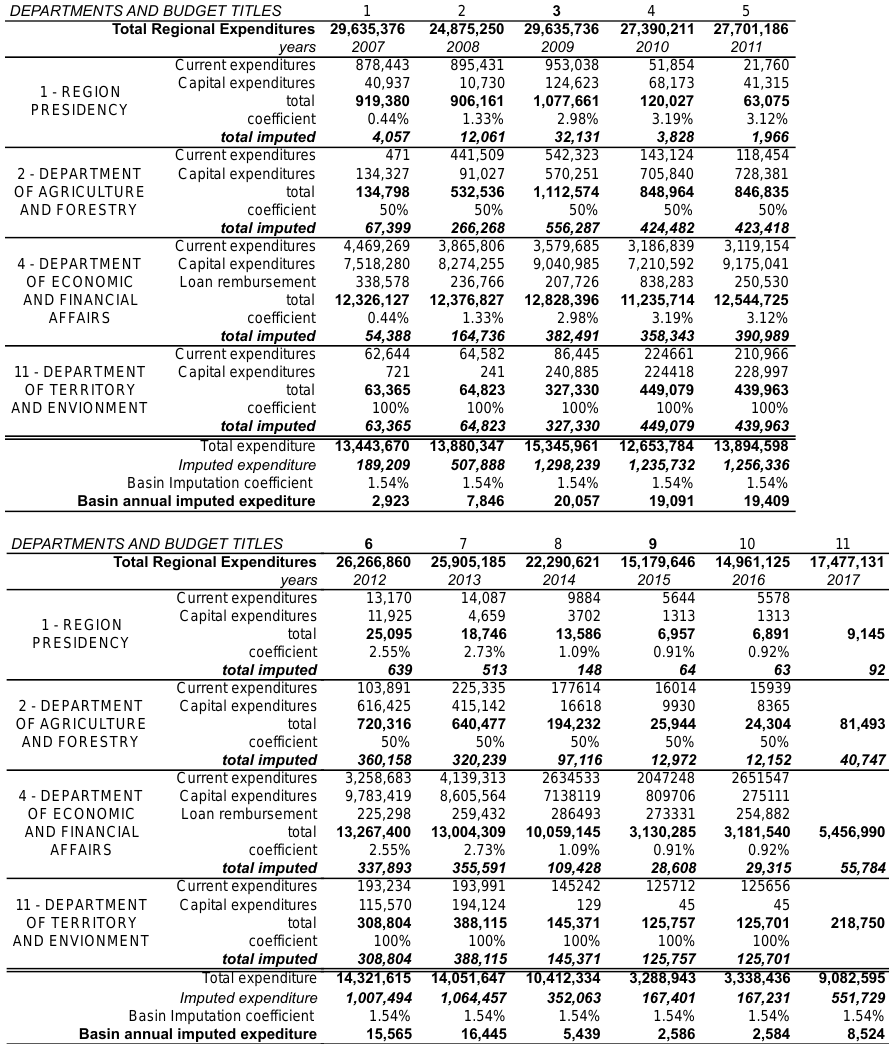
Figure 6. Sicilian Regional Government Balance Sheets 2007–2016 and imputation coefficient. Year 2017 reports the average amounts of the previous ten years